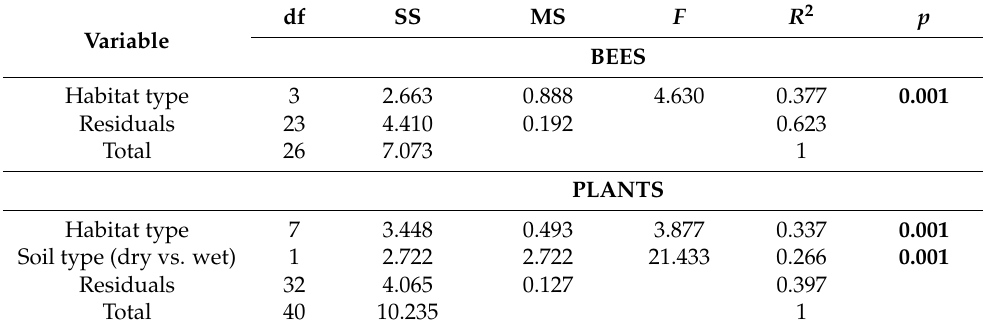
Table 2. PERMANOVA results for wild bee and plant communities based on Bray–Curtis distances.